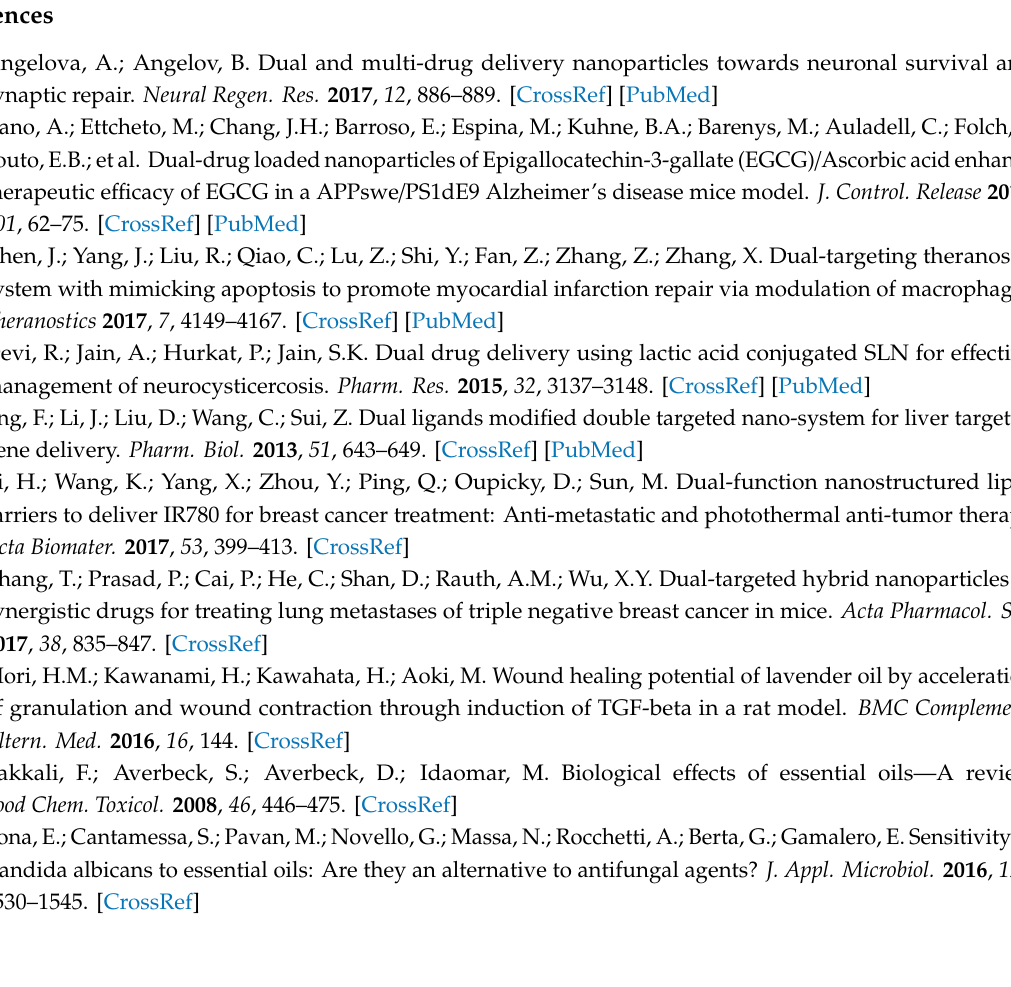
Figure S1: Survey Raman spectra of di ff erent analyzed systems. The regions of interest (850–1250 cm –1 and 2725–3125 cm –1 ) are enlarged and discussed in the text. Figure S2: Photographs of the gaps among fibroblast cells at 0, 24, and 48 h after incubation (at 37 ◦ C in 5% CO 2 and 95% relative humidity) with control, unloaded NLCa, and unloaded NLCb. Table S1: Quali-quantitative composition of blank and Fa-loaded NLC prepared using IPM (NLCa) or Lavandula EO (NLCb) as liquid oily phase. Table S2: Mean particle size (Zave, nm), polydispersity index (PDI) and zeta potential (ZP) ± standard deviation (SD) of unloaded and FA loaded NLC measured before and after purification. Table S3: Common vibrational Raman active modes in NLC formulations. Video S1: Turbiscan ® analysis of NLCa. The video shows the nanosuspension backscattering profile evolution over seven days of storage at 25 ± 2.0 ◦ C, highlighting the presence of an evident sediment in the deflocculated suspension. File created by Turbisoft-AGS Version 1. Video S2: Turbiscan ® analysis of NLCb. The video shows the nanosuspension backscattering profile evolution over seven days of storage at 25 ± 2.0 ◦ C, highlighting the presence of a flocculated suspension with greater stability. File created by Turbisoft-AGS Version